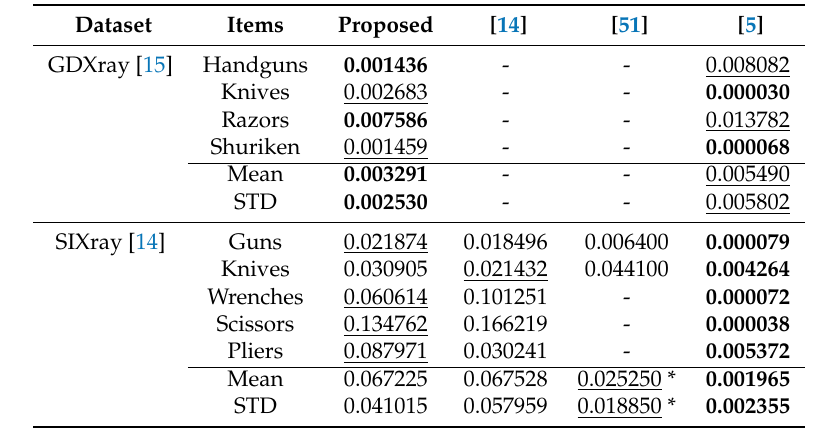
Table 5. Statistical significance of the proposed framework compared to the state-of-the-art solutions in terms of MSE . Bold indicates the best results, while the second-best performances are underlined. ’-’ indicates that the metric is not computed. Scores for the SIXray dataset represent the average of SIXray10, SIXray100, and SIXray1000